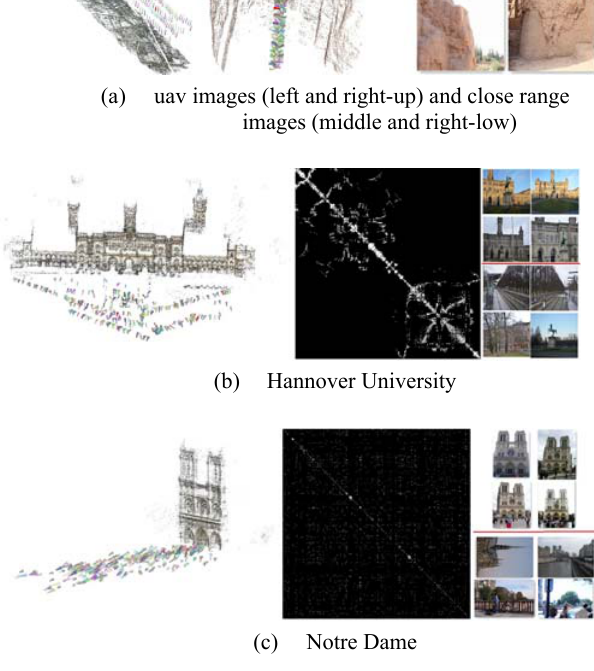
Figure 4. SFM results of three experimental image groups Fig. 4 depicts the result, coarse 3D reconstructions of the three experimental image groups, together with the similarity graph and a few sample images. As many off-diagonal elements of the similarity graphs are white, image acquisition in the second case occurred more ad hoc, and even random for Notre Dame. Images above the horizontal red bar of the right part of Fig. 4(b) and (c) are classified into clusters that contain more than 50 images and are used for sfm. Images below the bar are single images or images belonging to small size clusters which are discarded by our